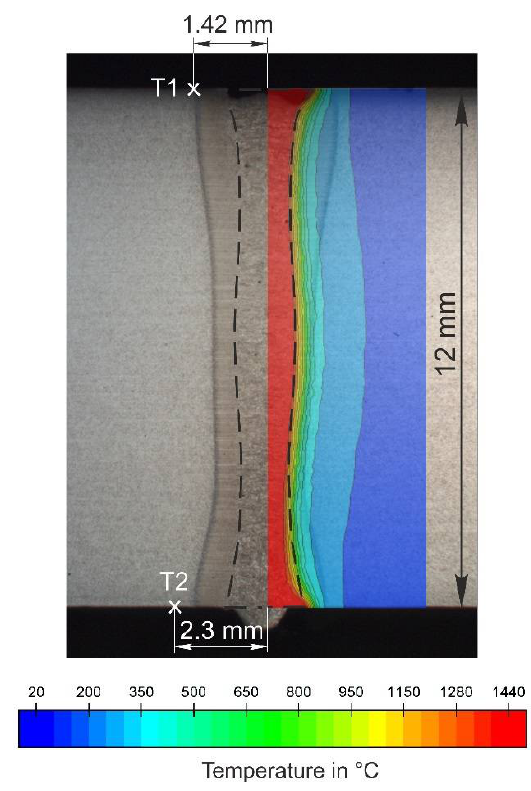
Figure 8. Comparison of the fused zone between experiment and CFD model.